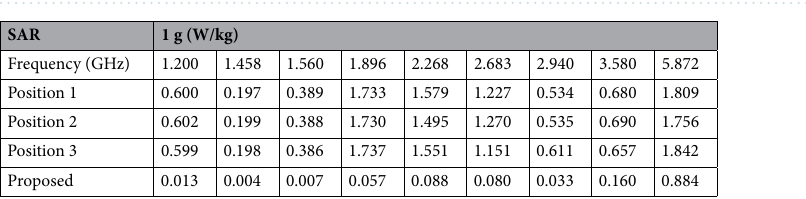
Table 7. SAR reduction values for 1 g of tissue volumes at various metamaterial positions.